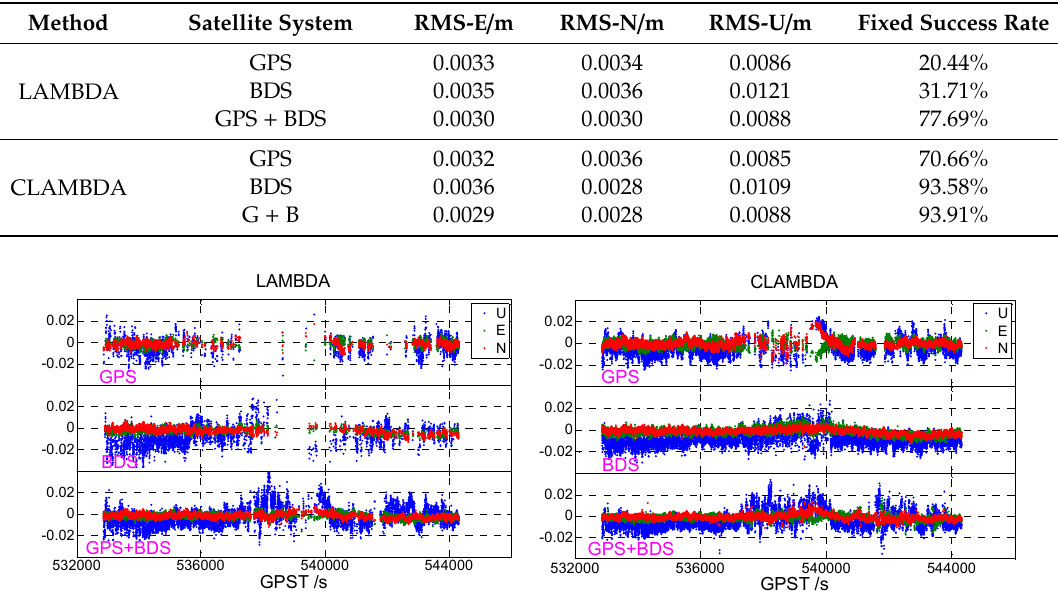
Figure 6. E/N/U deviation sequence diagram (( left ) LAMBDA, ( right ) CLAMBDA).